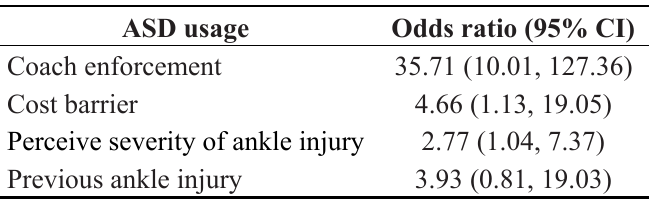
Table 5. The association between factors that predict ASD usage and actual ASD usage (odds ratios and 95%